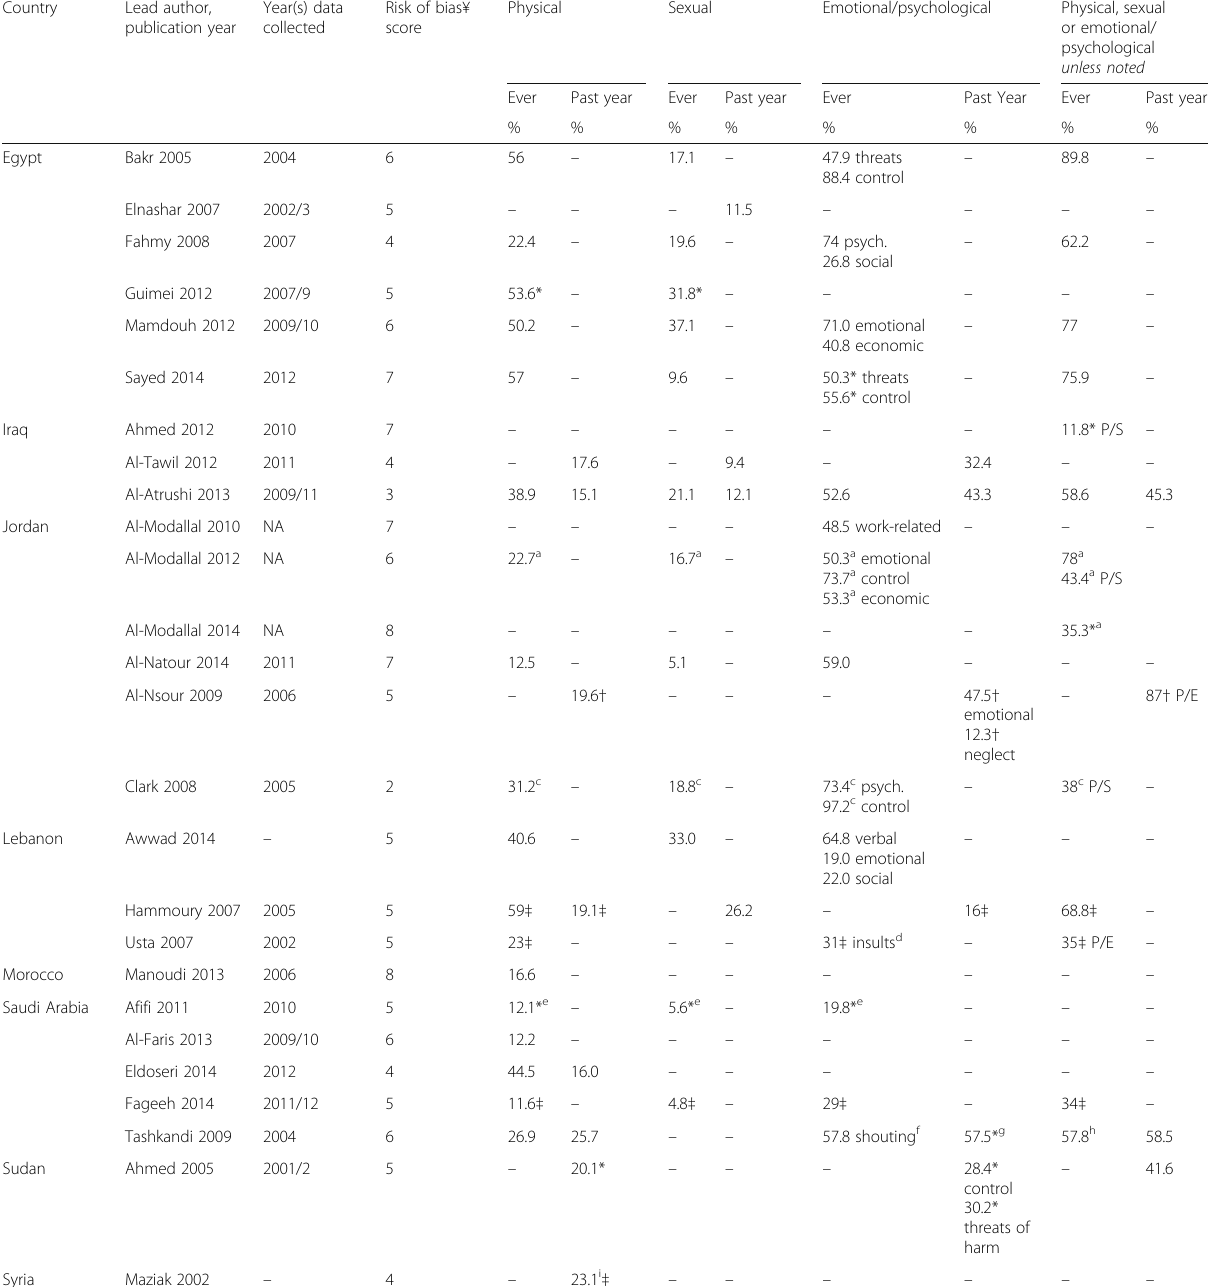
Table 5 Percentage of women reporting IPV, ever and past year, by type, facility-based surveys from journals